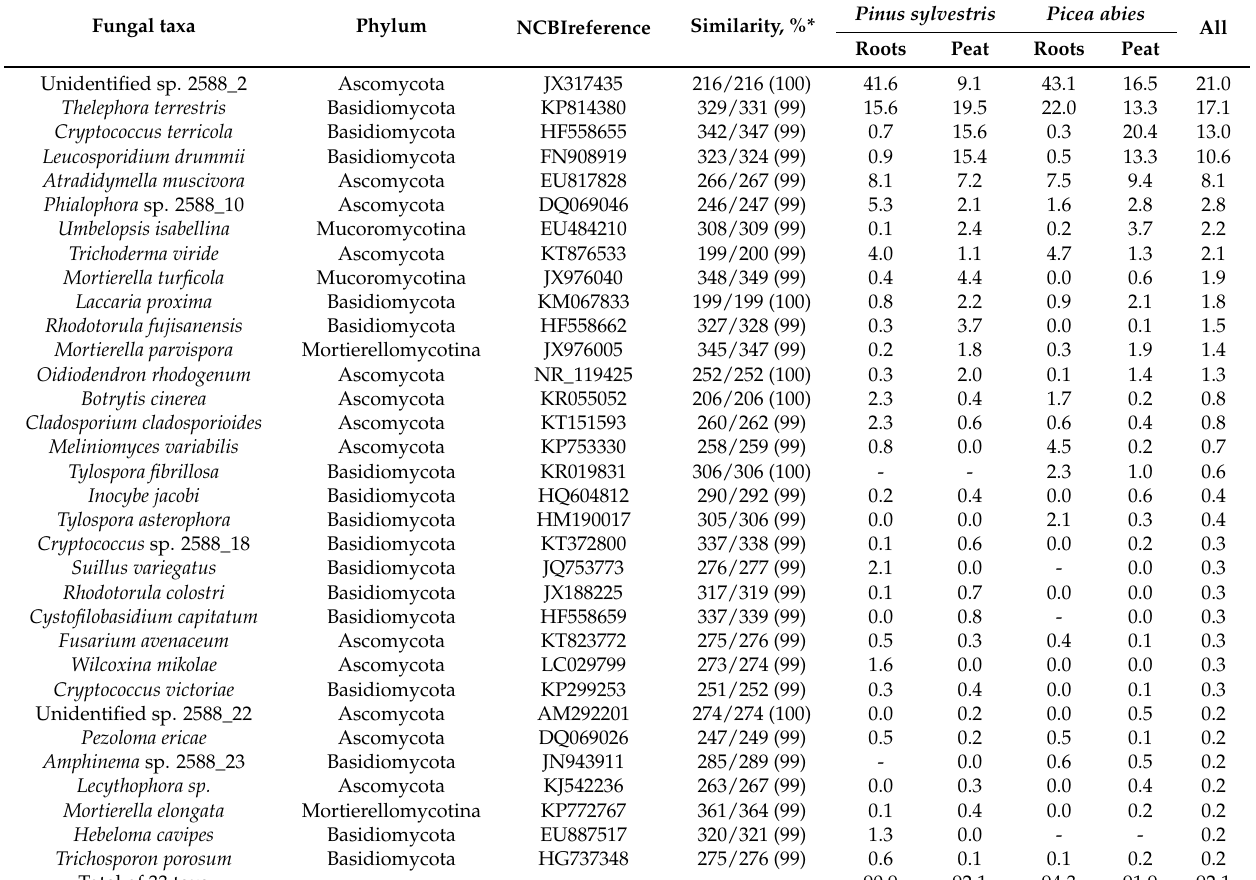
Table 2. Relative abundance of the 33 most common fungal taxa 454-sequenced from root systems ( roots ) and the sphagnum peat growth substrate ( peat ) of healthy-looking Pinus sylvestris and Picea abies seedlings from nine forest nurseries in Sweden. The data from different forest nurseries is pooled within each tree